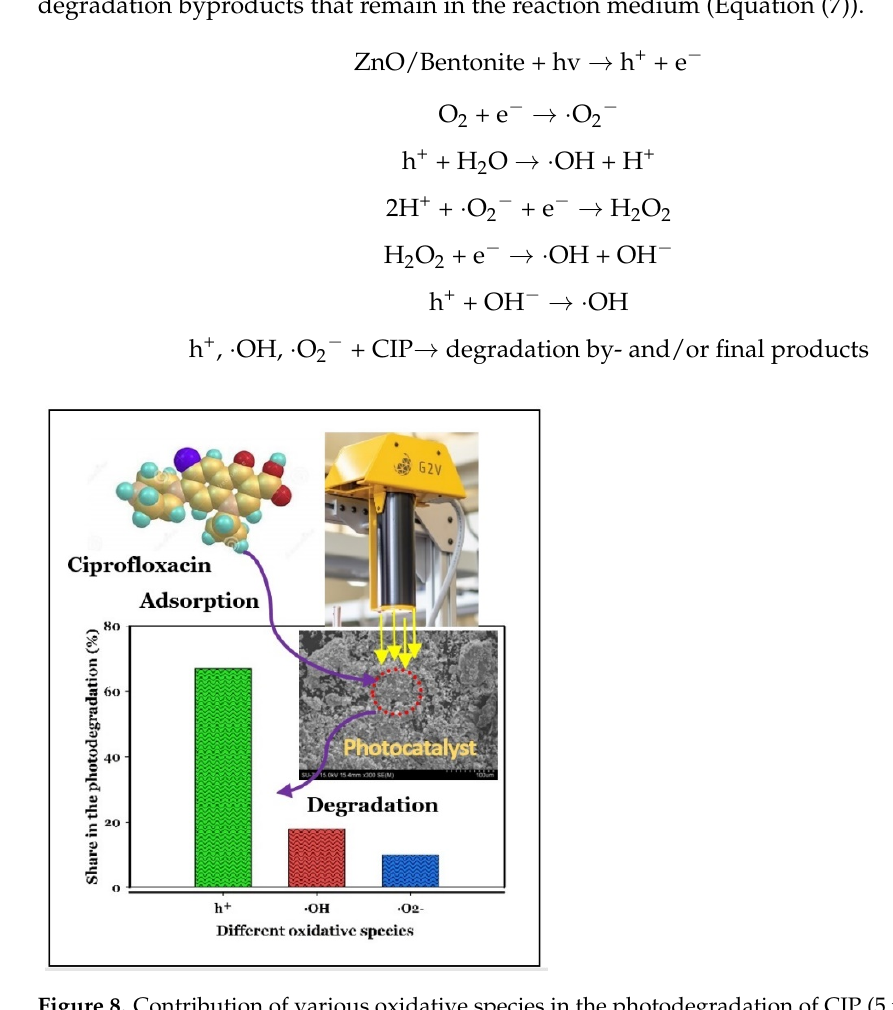
Figure 8. Contribution of various oxidative species in the photodegradation of CIP (5 mg/L) using ZnO/Bentonite (0.5 g/L).